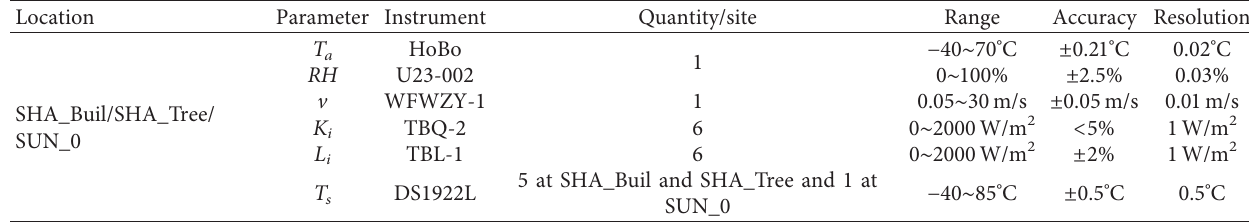
Table 1: Main technical parameters of the instruments.